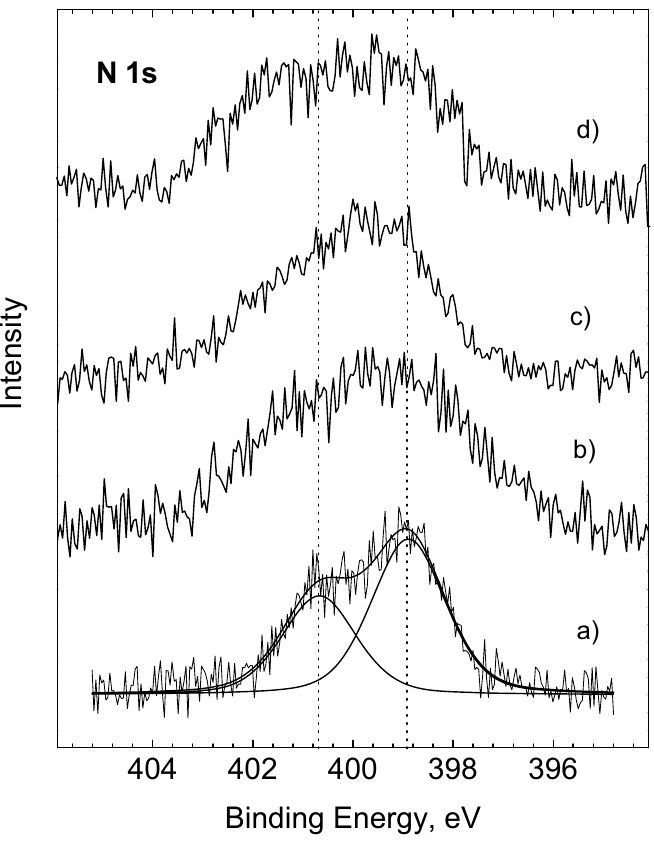
Fig. 6 The XPS N 1s core level of ODA (a), ODA-clinoptilolite (b), ODA-clinoptilolite with adsorbed chromate (c), ODA-clinoptilolite with adsorbed arsenate (d). of two types of bond. The lower energy peak is probably the ODA interaction with the aluminosilicate skeleton, while the higher energy one represents the interaction of